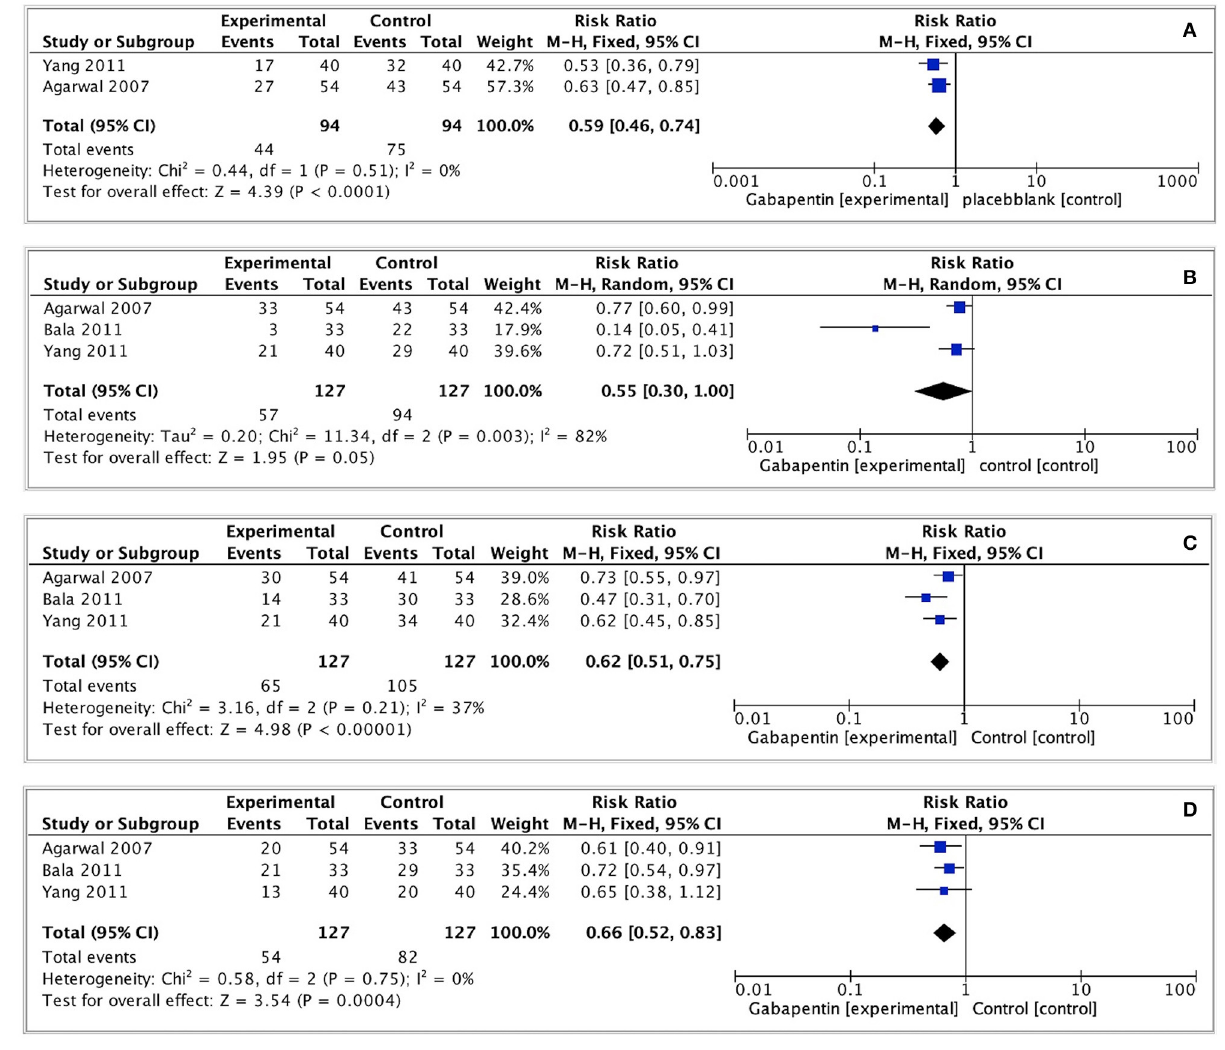
difference in postoperative sedation, nausea and vomiting,